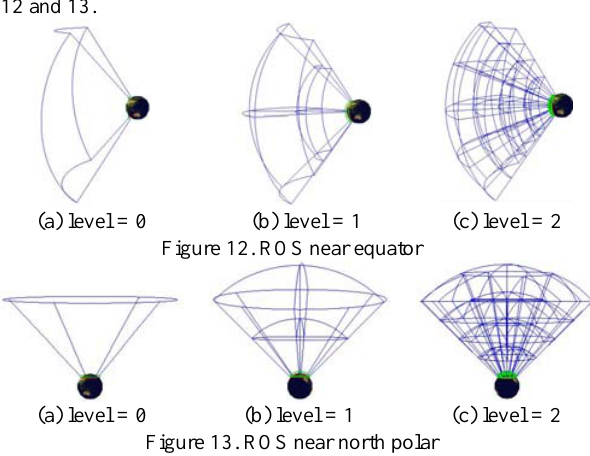
Figure 18. The e-Octree coding